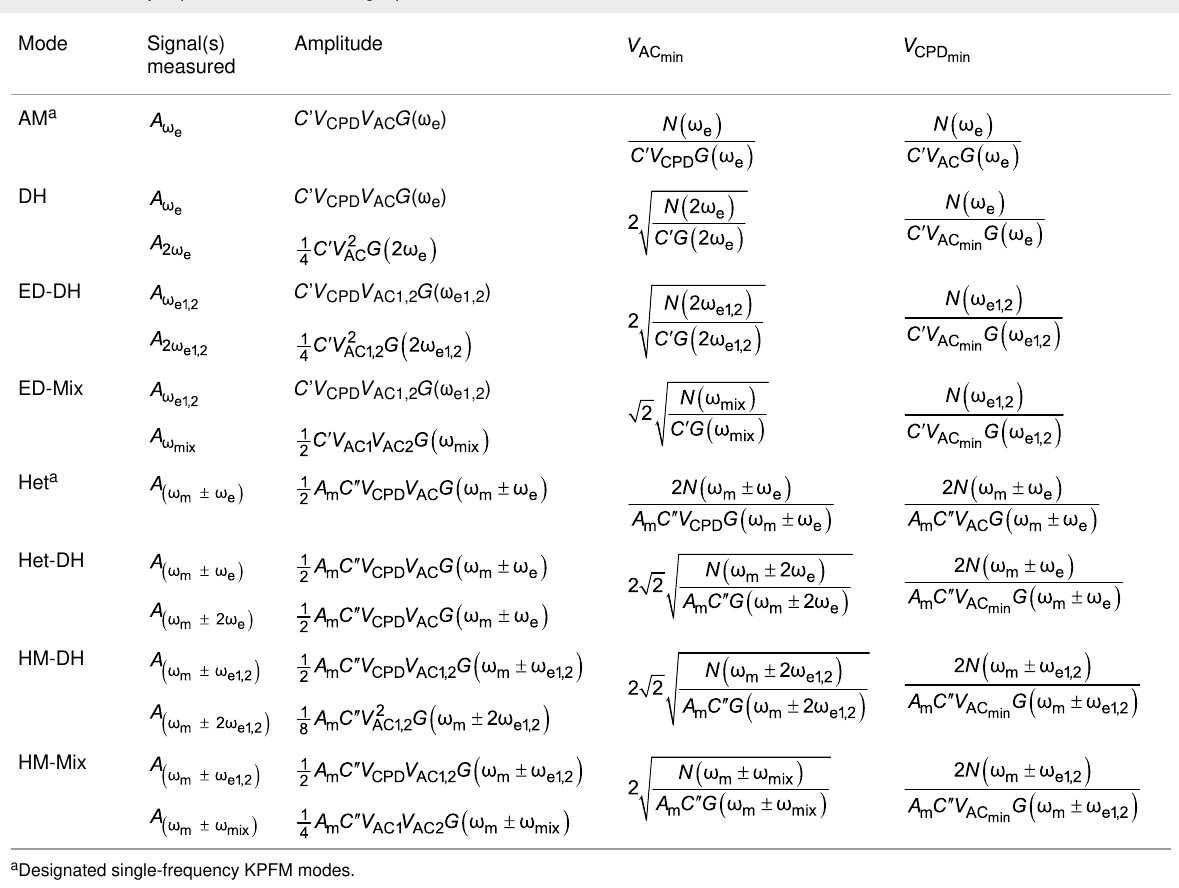
Table 1: Summary of performance determining